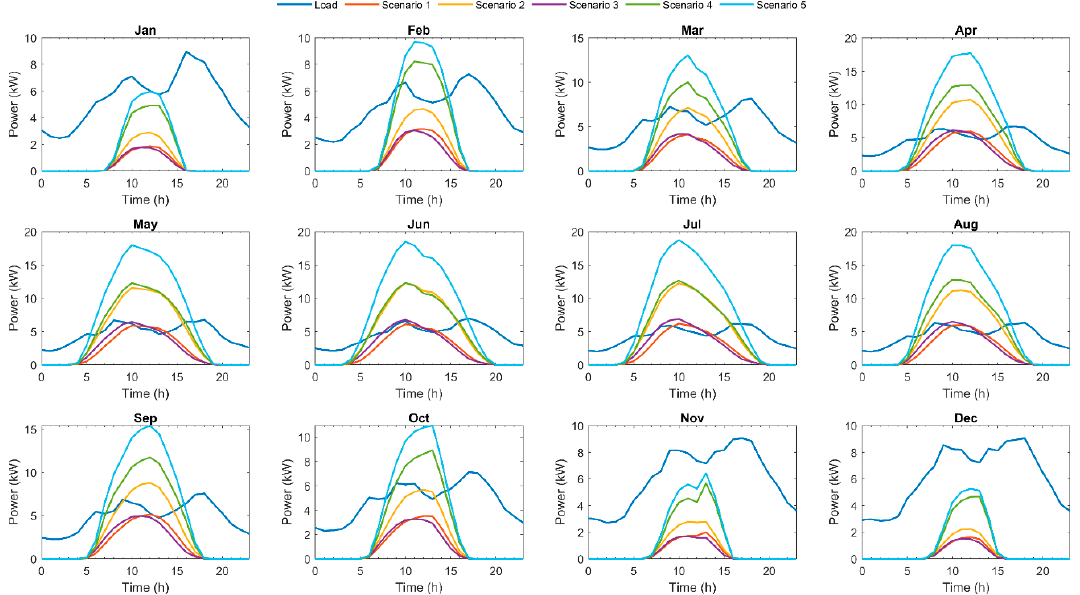
Figure 9. Typical hourly power profiles of the simulated scenarios and comparison with the building loads corresponding to the months of a year.